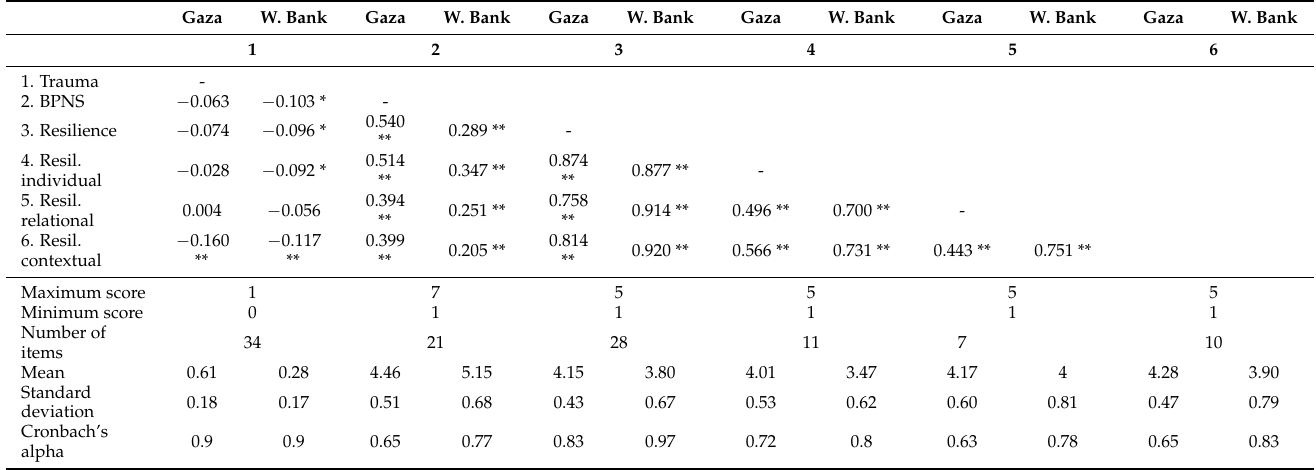
Table 1. Pearson’s correlations, maximum and minimum scores, number of items, mean, standard deviation, and Cronbach’s alpha for Trauma, BPNS, and Resilience for Gaza and the West